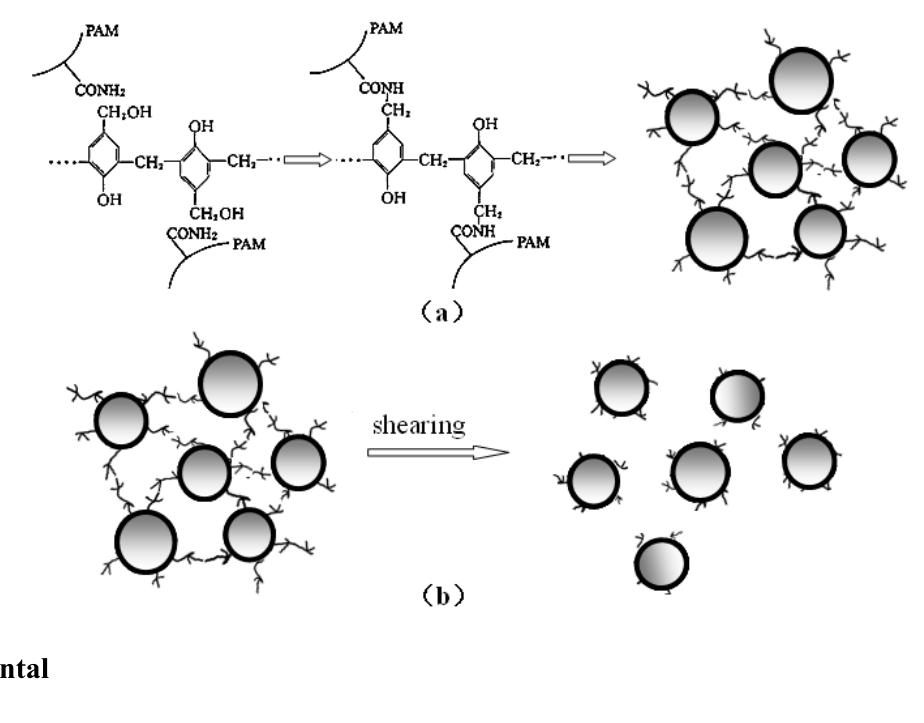
Figure 4. Proposed formation mechanism of the dispersed particle